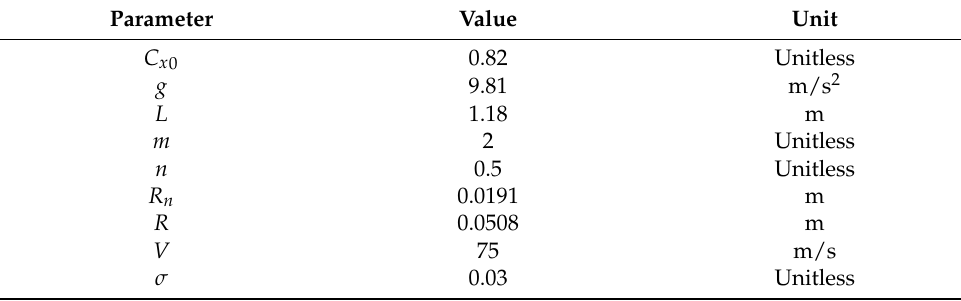
Table A1. Model parameters of the HSSV